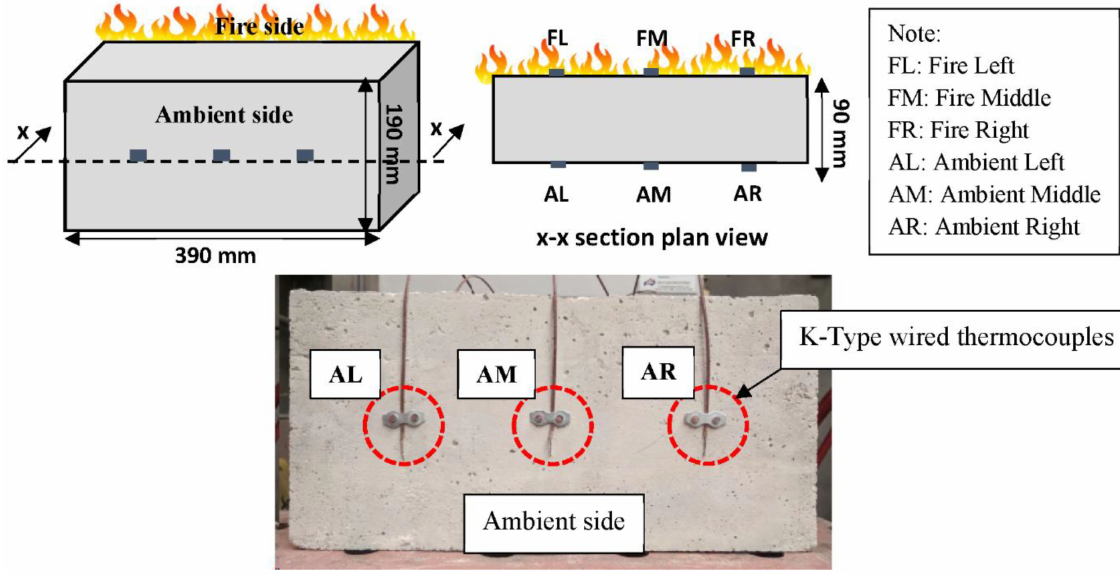
Figure 10. Thermocouple arrangement of masonry